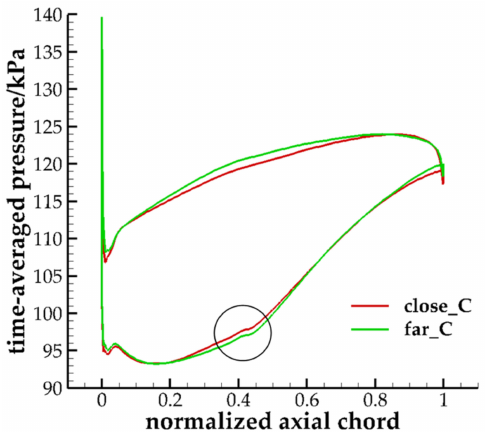
Figure 14. Time-averaged pressure distribution of the 0.05 span at C